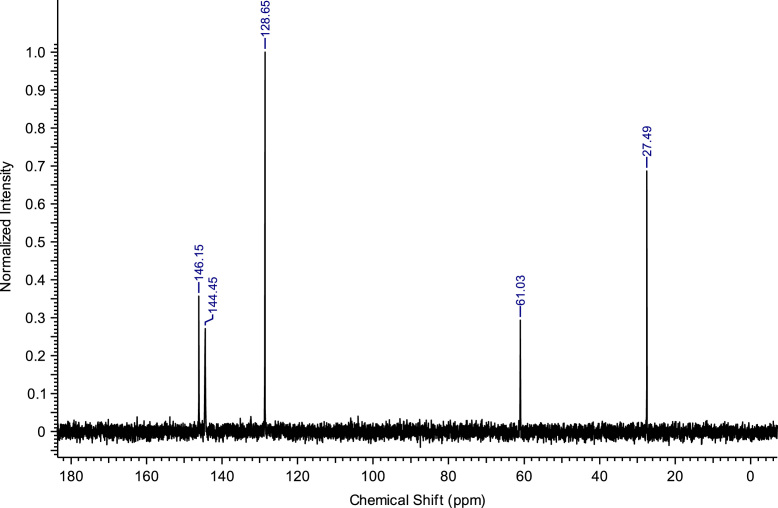
13C NMR spectra of C4(Pyr)2Br2.